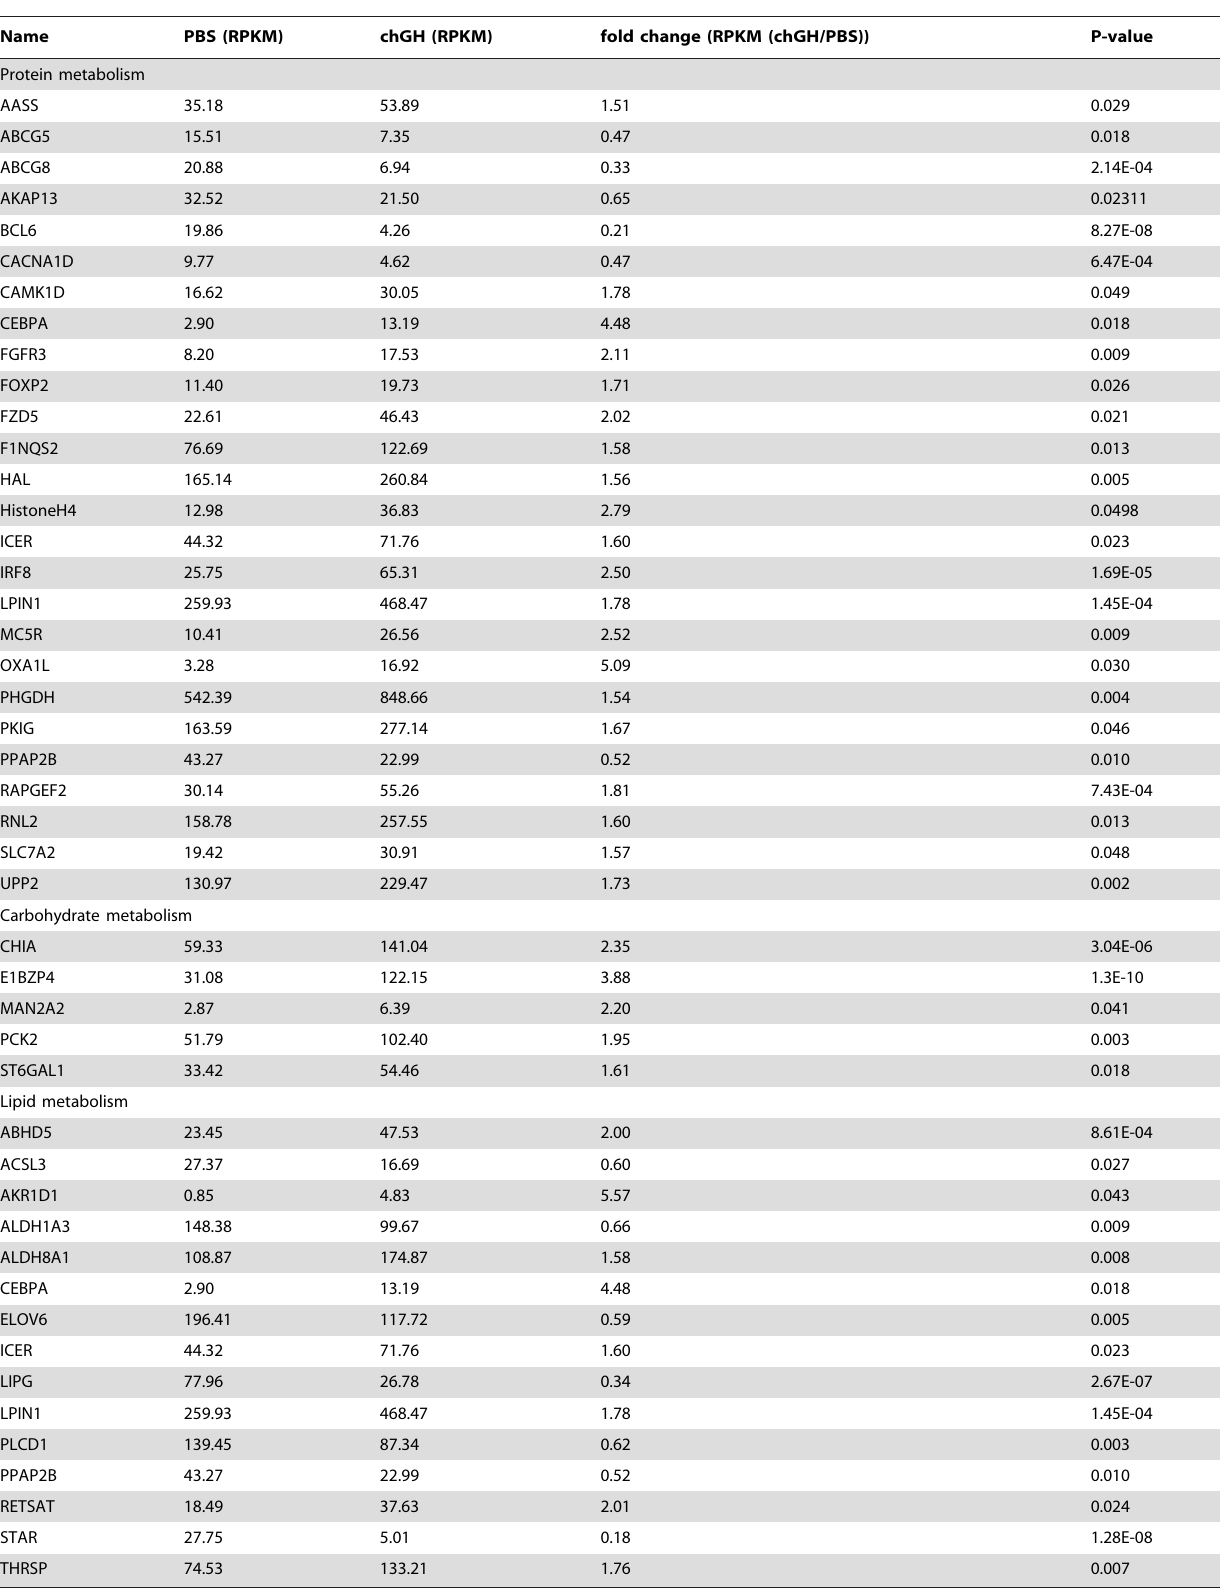
Table 5. List of metabolism-related mRNAs whose expression in chicken hepatocytes was regulated by chGH.